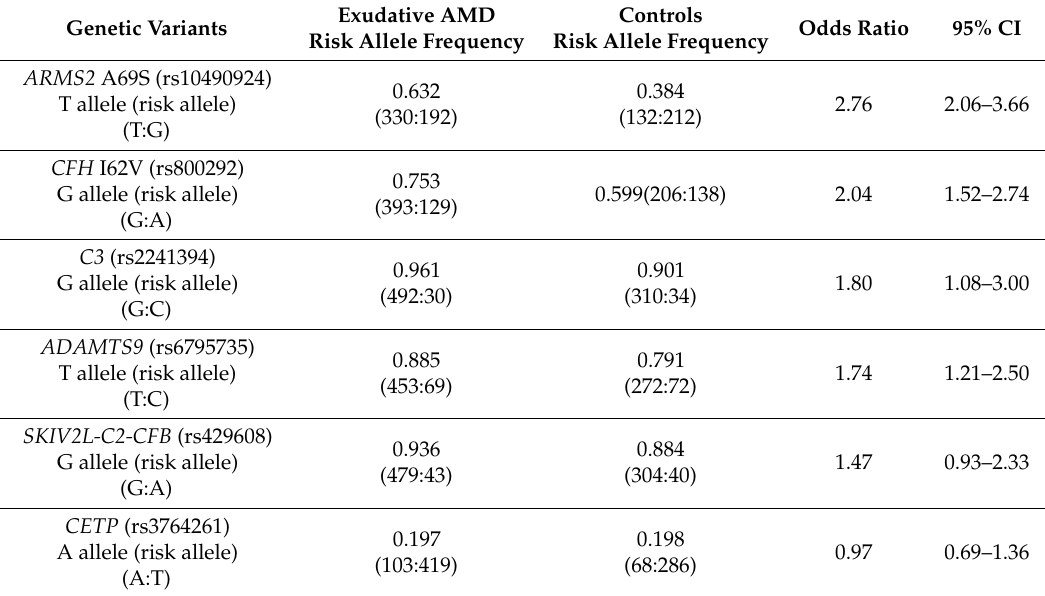
Table 2. Odds ratio in 6 genetic variants.